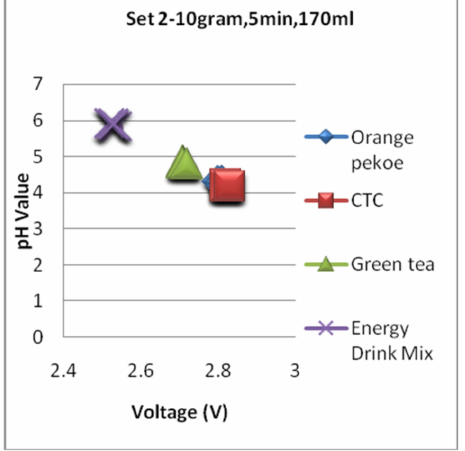
Figure 18. The voltagevs. pH plotting for Set 2.